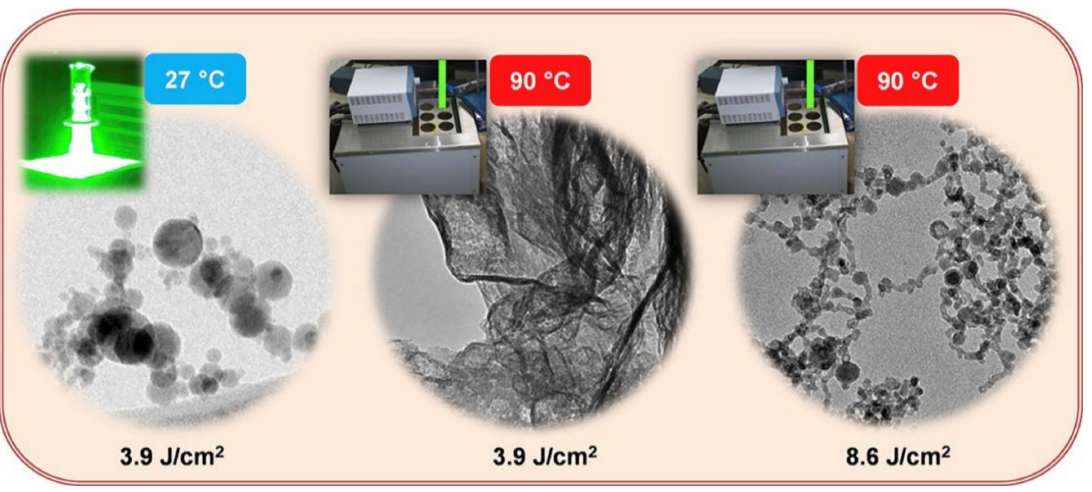
Figure 16. Transmission electron microscopy images of Zn nanoparticles at varying water tempera- tures and fluence ranges. Adapted with permission from Ref. [114]. Copyright 2015, Elsevier